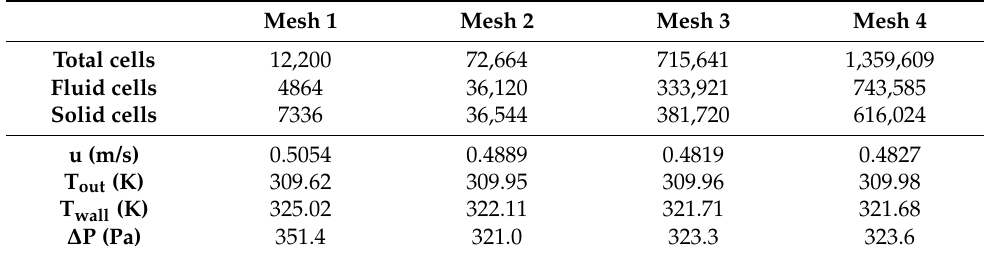
Table 1. The examined meshes for the reference